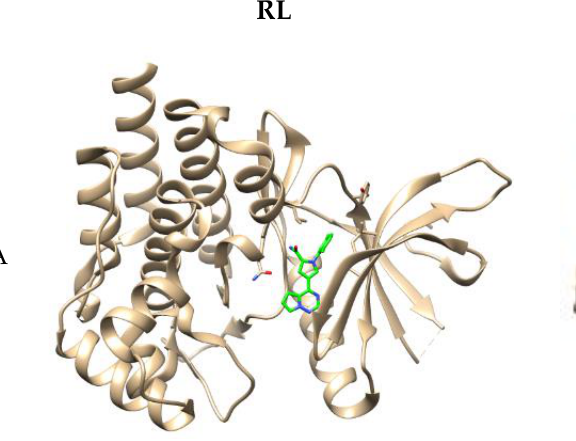
Figure 3. The interaction of compound 6c with CDK2 protein compared to reference ligand (RL), ( A ) 3D interaction, ( B ) hydrogen bond formation, and ( C ) hydrophobic interaction representation by blue color.